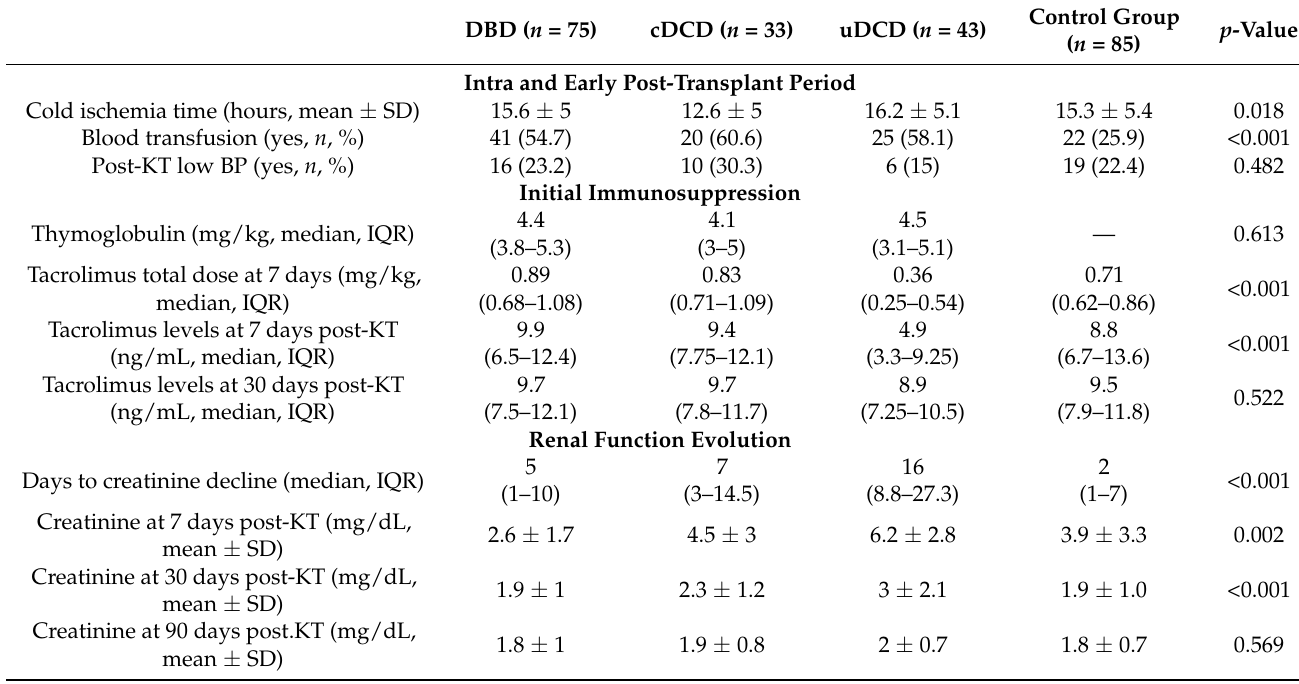
Table 2. Kidney transplant procedure features. Comparisons between groups were made with ANOVA or Kruskal-Wallis H tests according to its normal or non-parametric distribution (quantitative variables), and with Chi-Square test (categorical variables). DBD ( n =